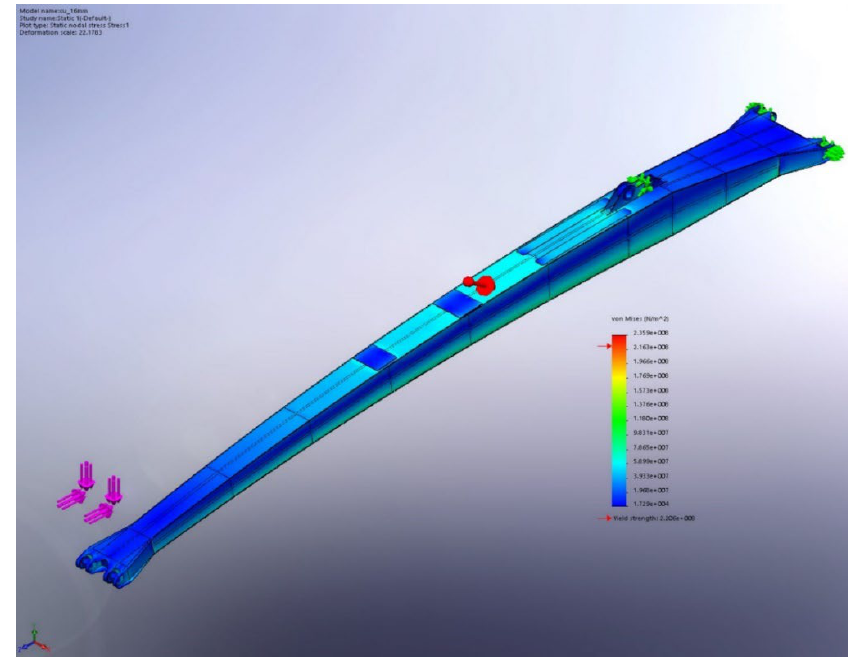
Figure 6. Equivalent normal stress—von Mises criterion.